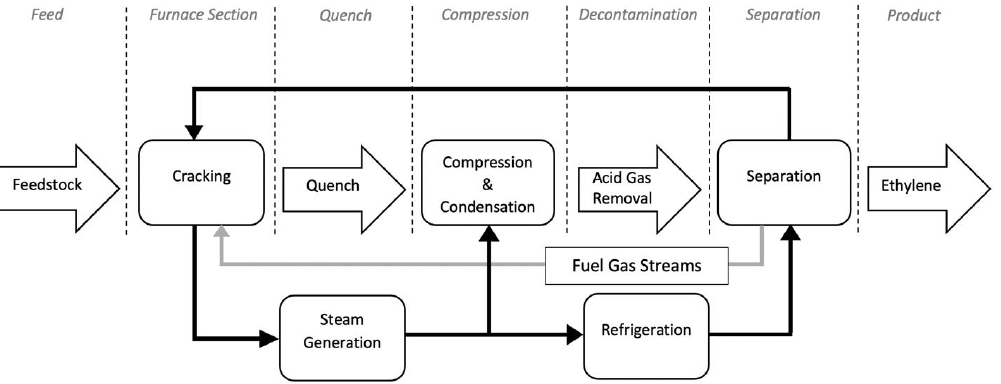
Figure 1. Block flow diagram of ethylene process by steam cracking [42].